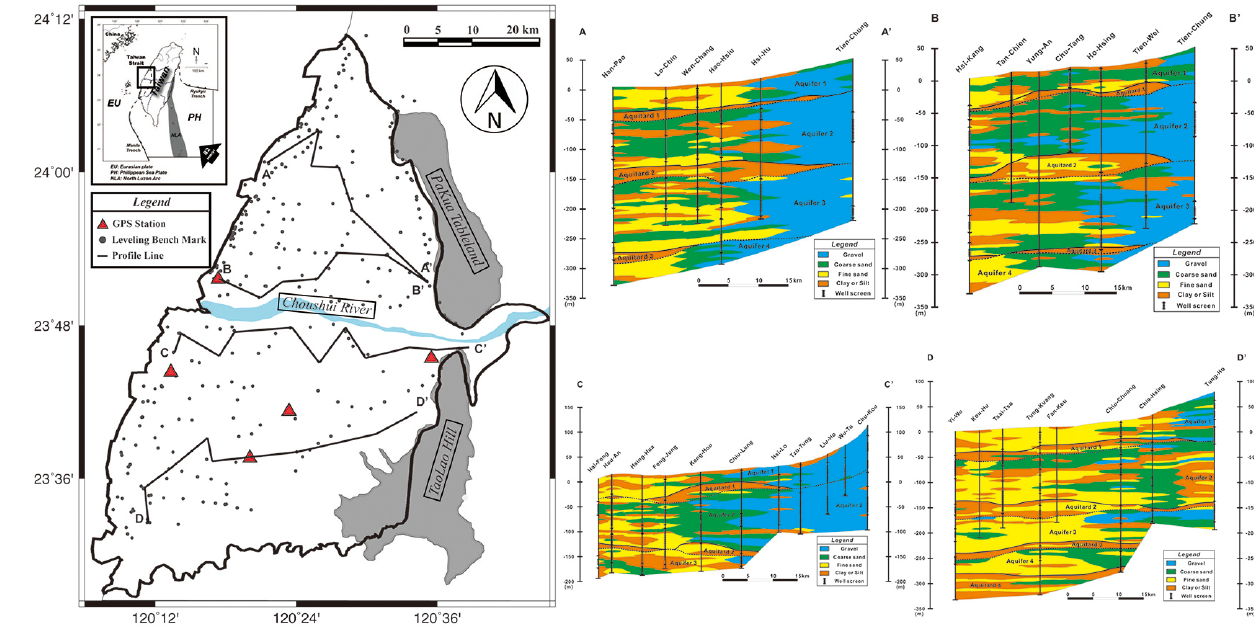
Figure 1. The study area. The black circle is the leveling benchmarks. The red triangle is continuous GPS station. The black lines indicate the location of hydrogeological profile. The right side of figure shows the hydrogeological profiles. The hydrogeological profiles were modified from Central Geological Survey